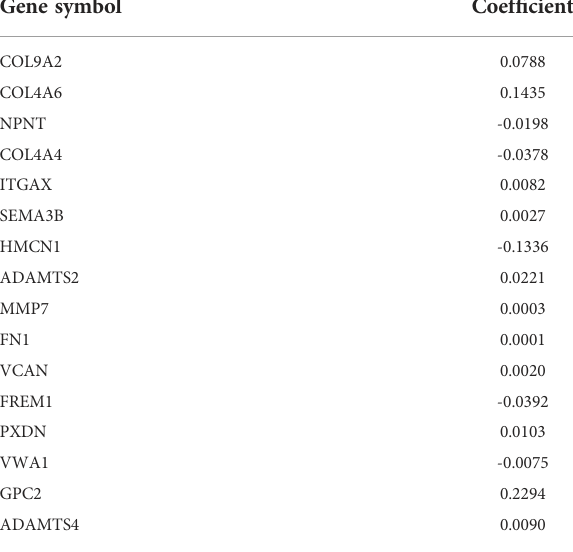
TABLE 1 The list of signature genes and their coef fi cients.